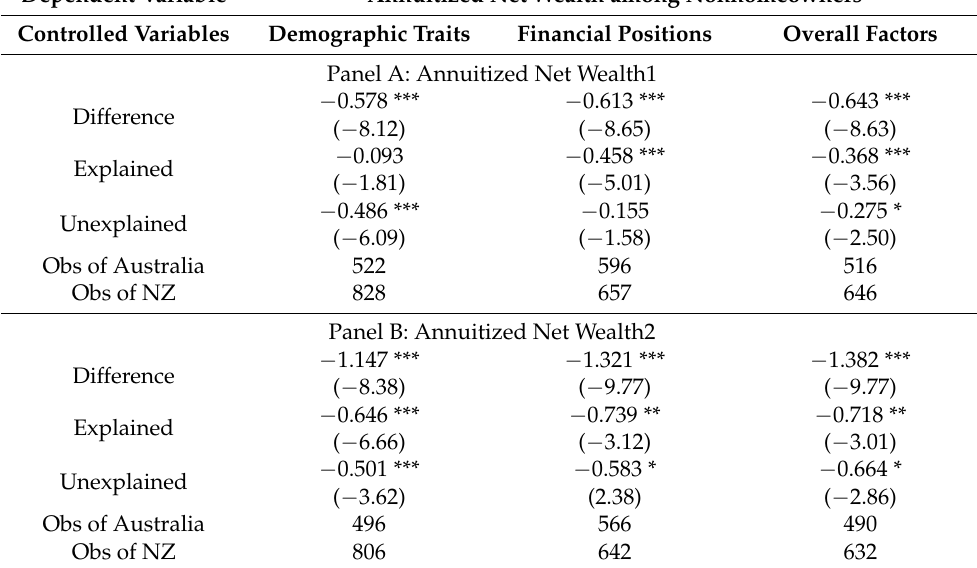
Table 14. Retiree income sufficiency decomposition among nonhomeowners in Australia and New Zealand. Dependent Variable Annuitized Net Wealth among